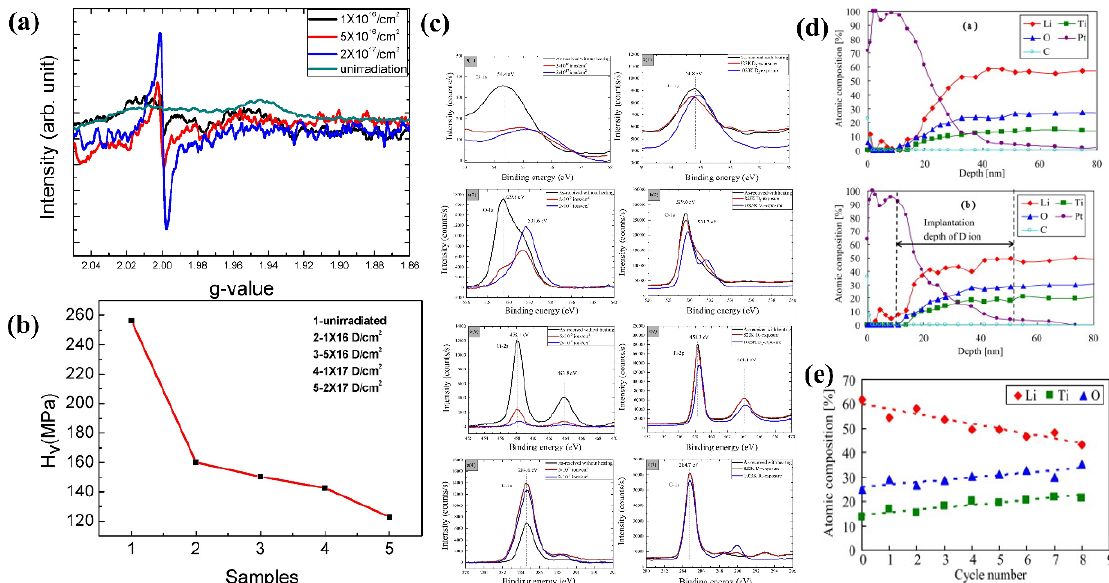
Figure 8. ( a ) ESR spectra for Li 2 TiO 3 samples before and after irradiation. ( b ) Vickers hardness of unirradiated and irradiated samples with different doses. Reprinted with permission from ref. [99]. ( c ) XPS spectra of deuterium-irradiated Li 2 TiO 3 and Li 2 TiO 3 as received without heating deuterium- exposed Li 2 TiO 3 and Li 2 TiO 3 as received with heating: Li-1s, O-1s, Ti-2p, and C-1s. Reprinted with permission from ref. [100]. ( d ) Depth profiles of atomic compositions of the Li 2 TiO 3 pebble without the irradiation/heating cycle and Li 2 TiO 3 pebble after the seven irradiation/heating cycles; The number of cycles is 7. ( e ) Surface atomic compositions of Li 2 TiO 3 pebbles with irradiation/heating cycles. Reprinted with permission from ref.